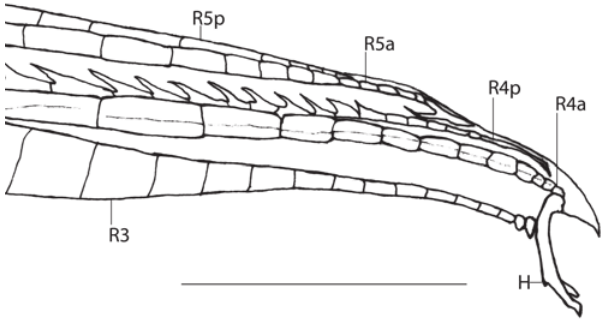
Fig. 22. Gonopodium tip of Phalloceros elachistos , MCP 30023. R3, R4a, R4p, R5a, R5p indicate gonopodial rays. Scale bar 1